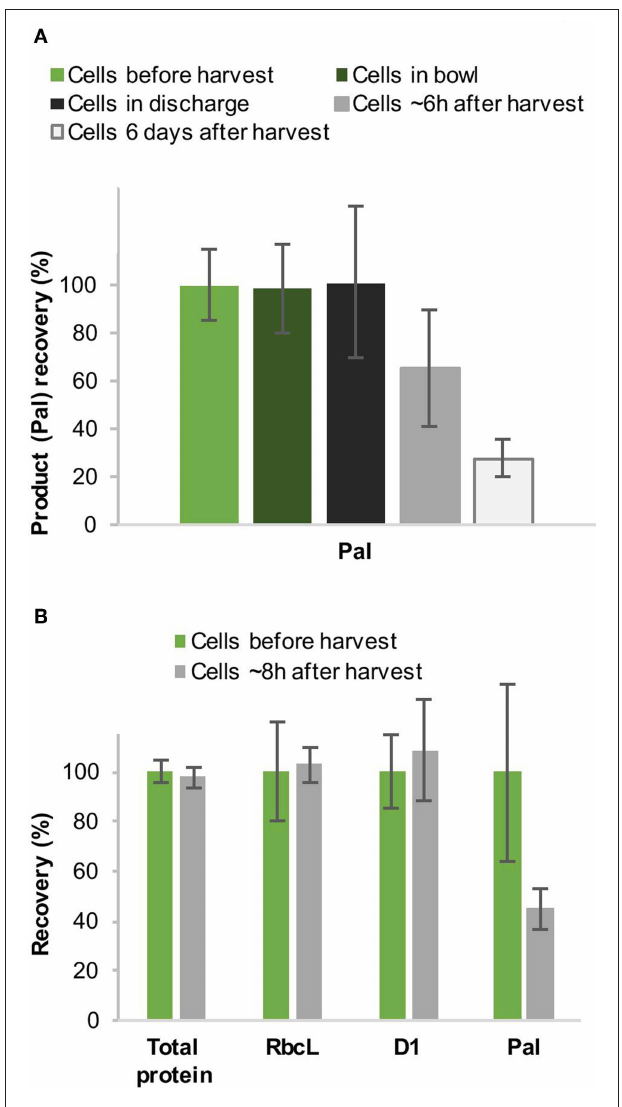
FIGURE 6 | Recovery (%) of the recombinant protein Pal during harvest by continuous-flow intermittent-discharge disc-stack centrifugation (A) and comparison to the recovery of endogenous proteins (B) . Chlamydomonas reinhardtii TN72_pal pilot-scale cultures were harvested in a GEA Westfalia CSA-1 at a flow rate of 150L.h − 1 (Q/ 6 65 × 10 − 9 m.s − 1 ) (A) and 250L.h − 1 [(Q/ 6 109 × 10 − 9 m.s − 1 ] (B) , respectively. The amount of Pal, D1 and RbcL in the cell material was determined by quantitative western blot analysis, and the total protein by Coomassie-stained SDS-PAGE. Error bars represent ± 1 SD ( n ≥